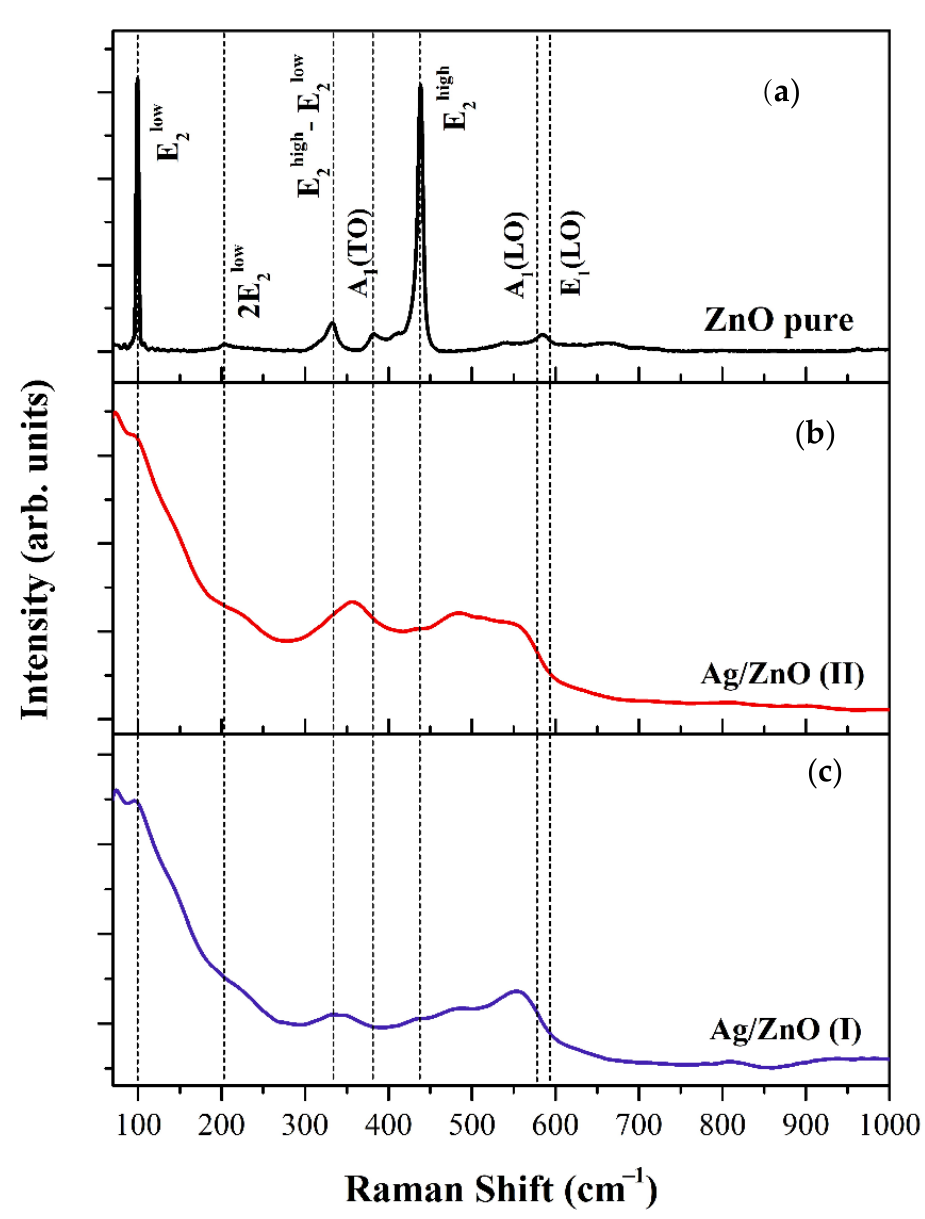
Figure 3. Raman spectra of synthesized ( a ) pure ZnO, ( b ) Ag/ZnO (I), and ( c ) Ag/ZnO (II) using starch and Aloe Vera Barbadensis miller extract.